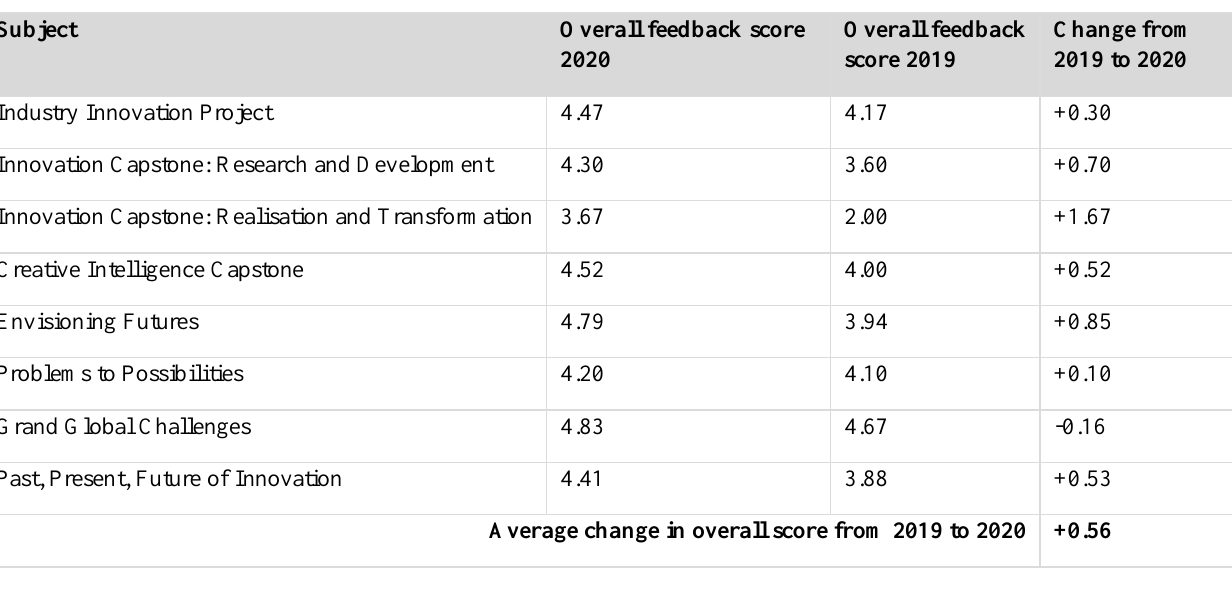
Student Feedback Survey Scores for the Subjects